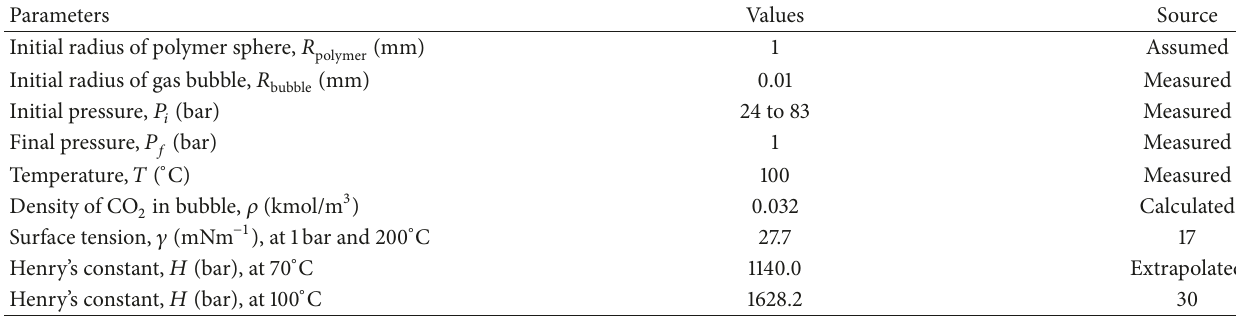
Table 1: Models general parameters values.